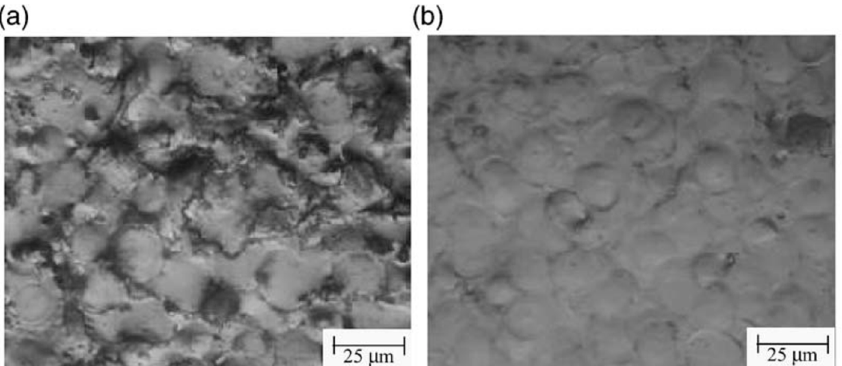
Figure 9. Variation of machined H13 surfaces achieved by ( a ) conventional EDM process and ( b ) powder-mixed EDM by using electrodes with an area of 32 cm 2 [54]. (With kind permission from Elsevier).